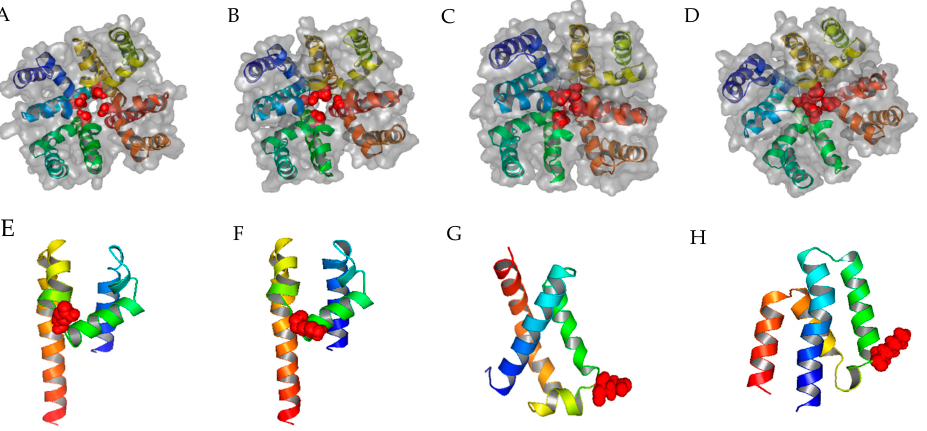
Figure 1. Top views of homology modeling results from ZMM for α 1 C, α 1 G, α 1 H, and α 1 I. ( A – D ) The structures of α 1 C, α 1 G, α 1 H, and α 1 I, respectively; blue, green, brown, and yellow represent domains I, II, III, and IV, respectively; the four selectivity-determining amino acids (glutamic acid or aspartic acid) in the P-loop are colored red and displayed as spheres; ZMM generates more consistent 3D structure than the ab initio modeling method for α 1 C and α 1 G; ( E ) the predicted 3D structure of the α 1 C domain III generated by ZMM, the glutamic acid is represented by red spheres; ( F ) the predicted 3D structure of the α 1 G domain III generated by ZMM, the lysine is represented by red spheres; ( G ) the most representative structure selected by Calibur clustering analysis [16] of α 1 C domain III, the glutamic acid is represented by red spheres; ( H ) the most representative structure selected by Calibur clustering analysis of α 1 G domain III, the lysine is represented by red spheres.